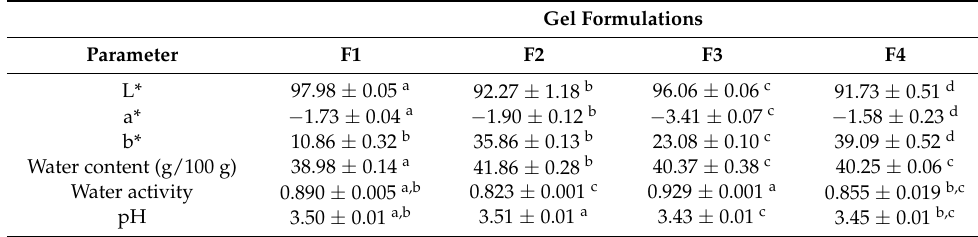
Table 1. Physical properties of the gel formulations.